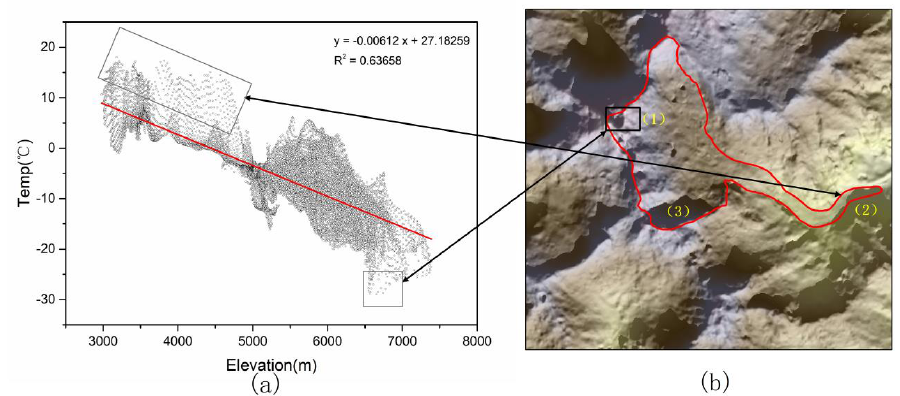
Figure 12. The relationship between the anomaly and topographic shading: ( a ) the variation in the GSTs with elevation (10 November 2018); ( b ) the topographic shading of the Hailuogou glacier.